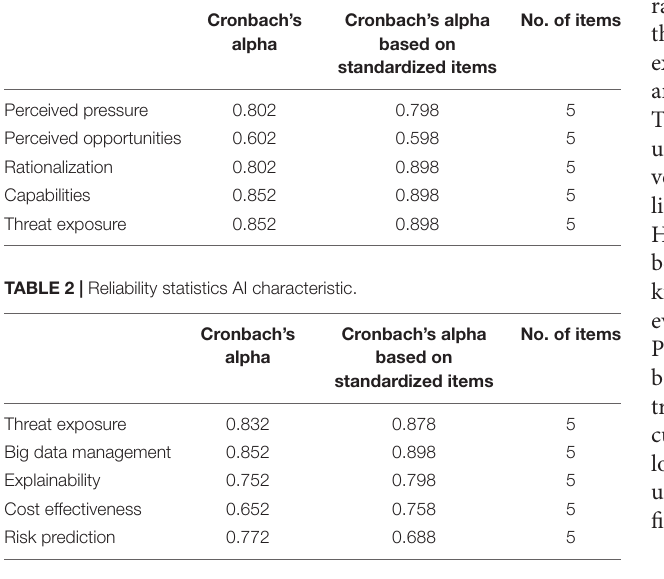
TABLE 1 | Reliability statistics fraud diamond theory.